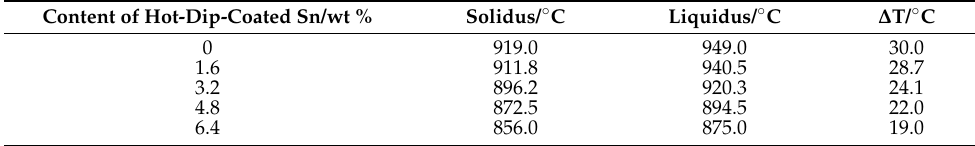
Table 5. Melting characteristics of BCu68Zn filler metals with different contents of Sn [51]. Content of Hot-Dip-Coated Sn/wt